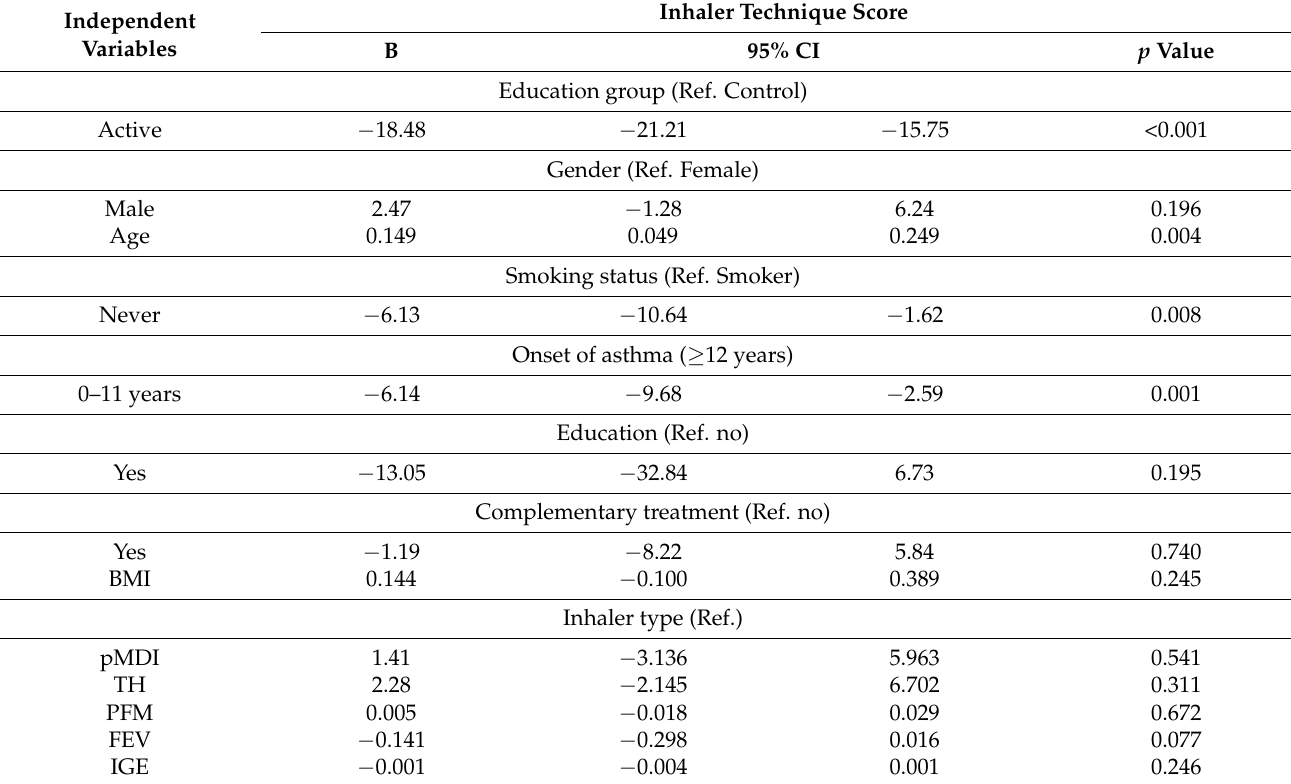
Table 6. Selecting the set of factors that jointly influence the use of inhaler technique for study participants ( n = 245). Independent